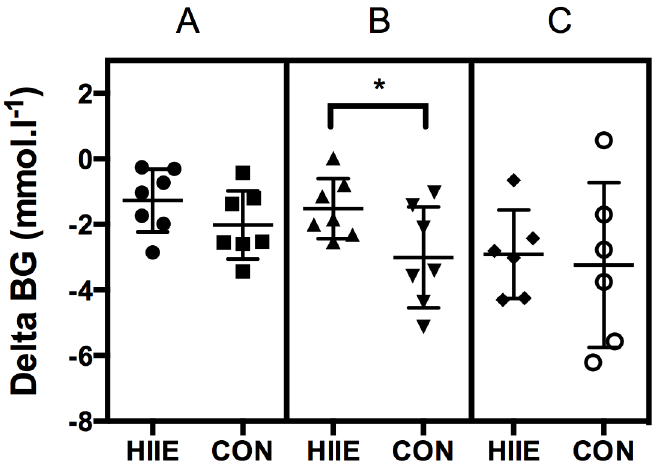
Fig 5. Comparison of delta blood glucose (BG) during high-intensity interval exercise vs. continuous exercise for mean exercise intensities A, B, and C. Values are given as mean and SD. “ * ” represents significance.